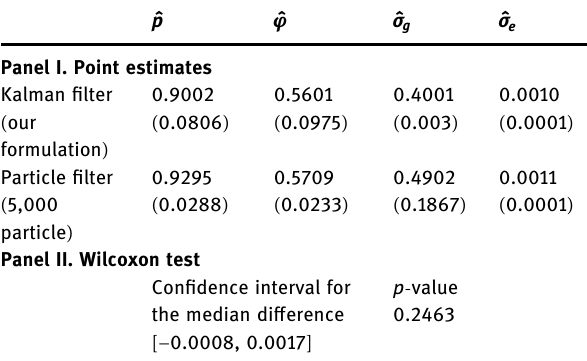
Table 2: Comparison after the fi nancial crisis p ˆ φ ˆ σ ˆ g σ ˆ e Panel I. Point